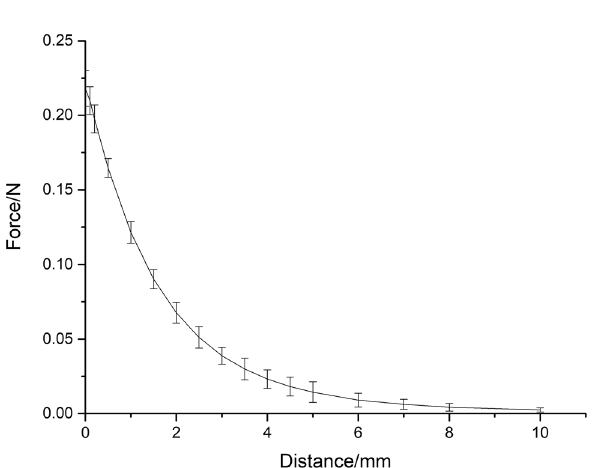
Figure 3. Comparison of gel properties before and after adding magnetic powder. ( a ) Storage modulus. ( b ) Loss modulus.